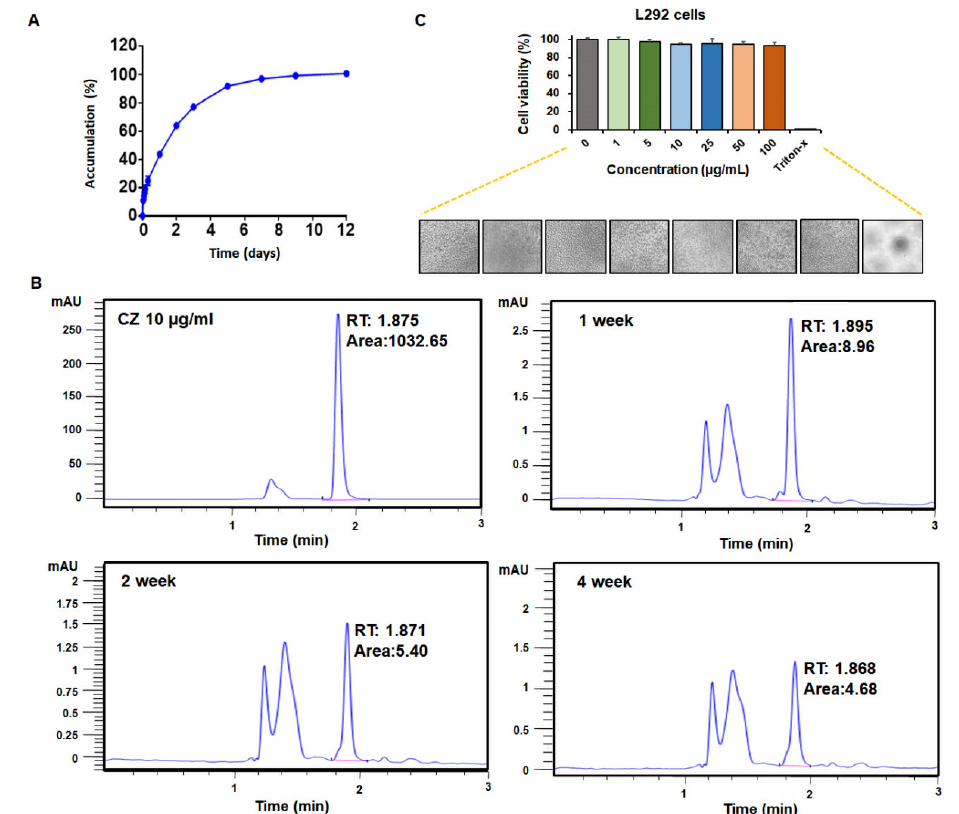
Figure 4. Characterization of CZ release kinetics and cytocompatibility of CZ-PLGA-NPs. ( A ) In vitro CZ release profile of CZ-PLGA-NPs; ( B ) Stability of released CZ in CZ-PLGA-NPs. Representative high-performance liquid chromatogram of released CZ in CZ-PLGA-NPs after one, two, and four weeks. Numerical data represent the mean ± standard deviation (SD) of three independent experi- ments. ( C ) In vitro cytotoxicity of the drug-free PLGA-NPs on L929 cells and light microscopy images of L929 cells after a 24 h co-incubation.